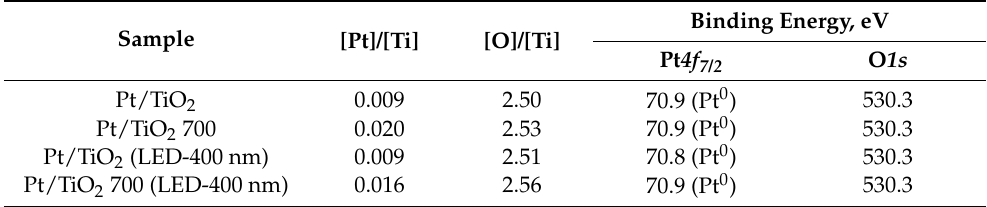
Table 1. Relative atomic concentrations of elements in the surface area of the catalysts under study and Pt 4f 7/2 and O 1s binding